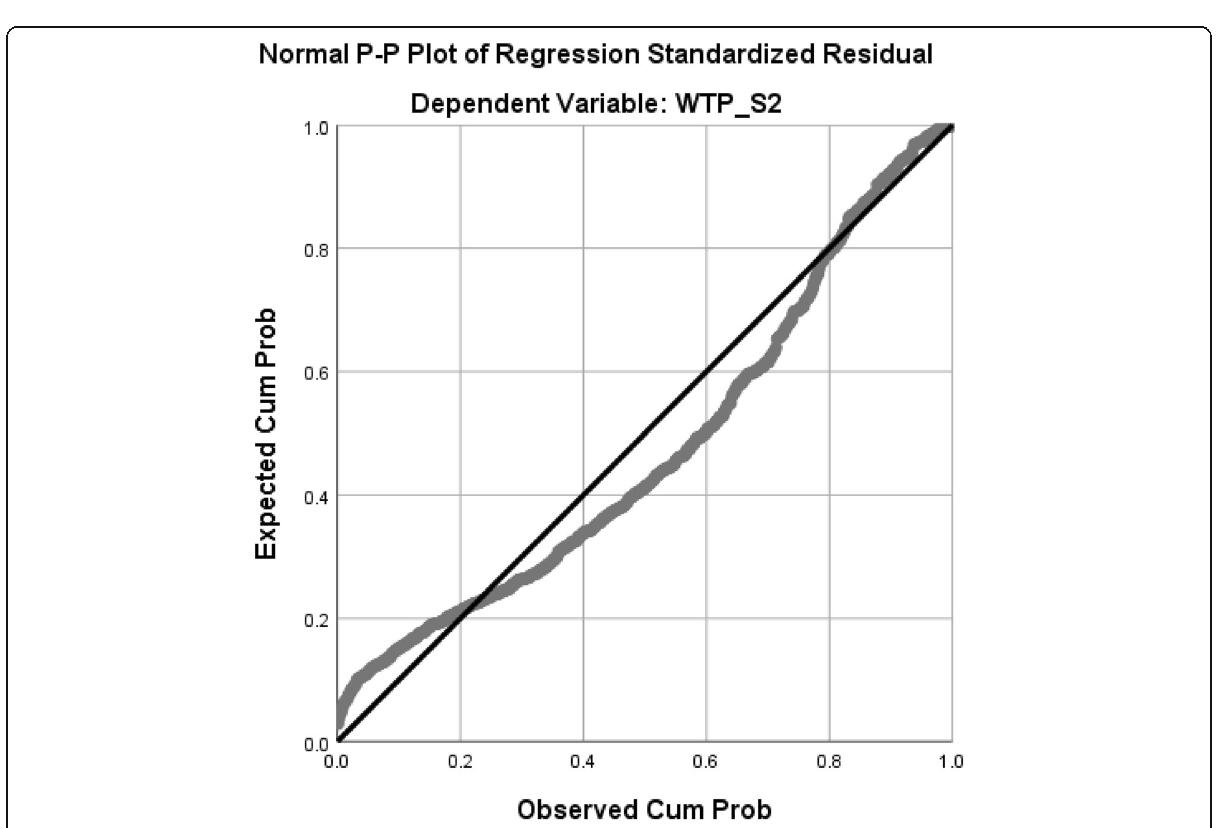
Fig. 10 Normal P-P Plot of the residuals of regression of Model B (explanatory variables against WTP for